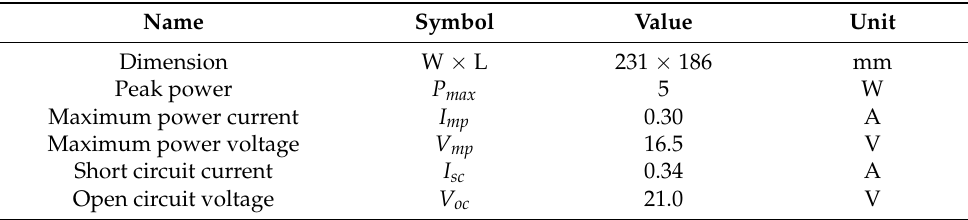
Table A2. Detailed parameters of the 5 W PV panel under standard test conditions.